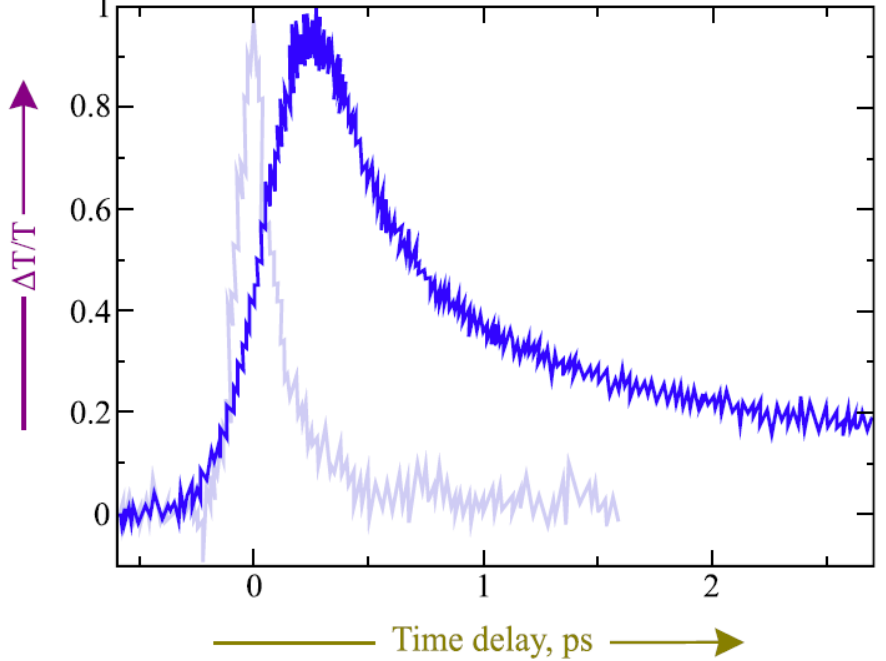
Figure 15. Typical relaxation times of single-walled carbon nanotubes: black color shows relaxation time for 0.8 eV energy and gray color shows relaxation time for 1.47 eV energy.